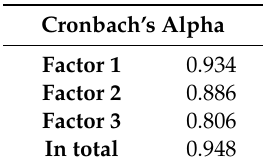
Figure A2. Parallel analysis of participant profiles by dendrogram clusters. Table A2. The Values of Cronbach’s alpha.